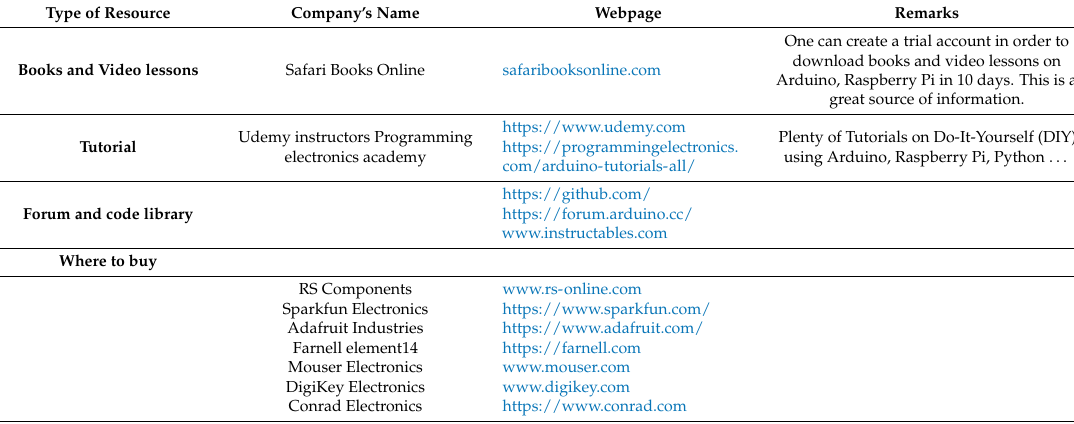
Table 2. List of resources to help the beginners to get